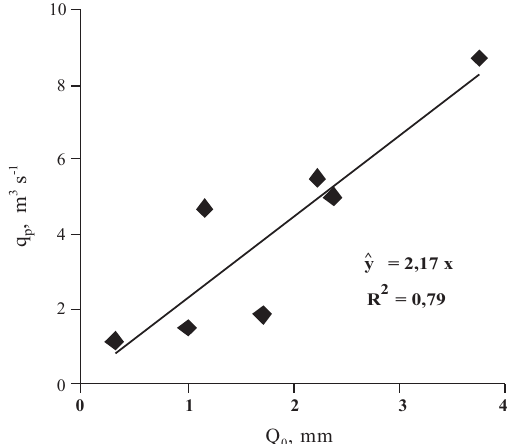
Figura 4. Relação entre os volumes de escoamento superficial (Q